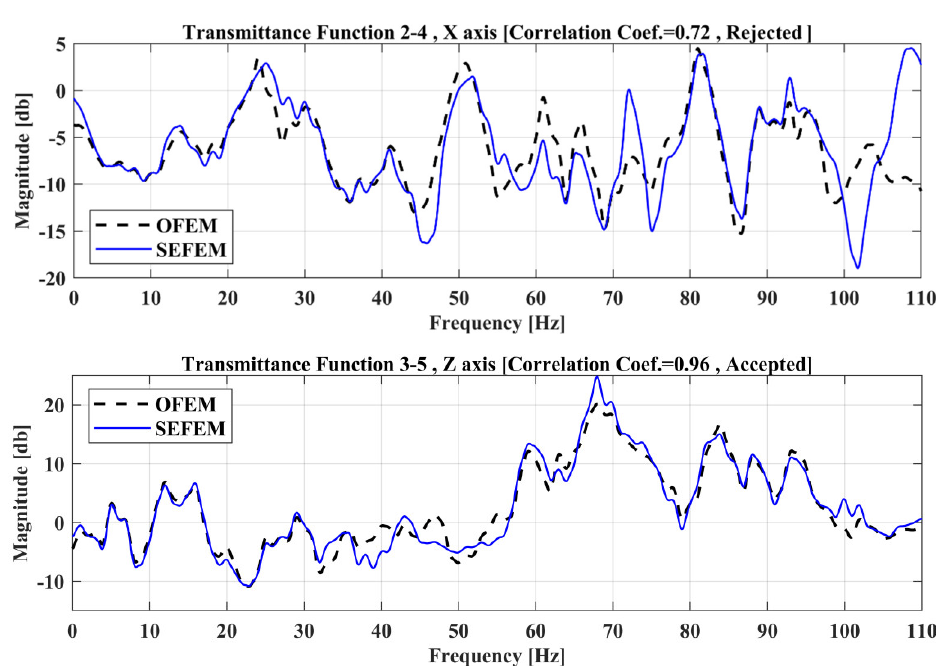
Figure 6. Indicative TFs of the vehicle between the OFEM and SEFEM. Two damaged cases are examined. At the first (Case 1), a crack is opened at the SEFEM at Part 6 of the structure, simulated with a split between specific elements. In the